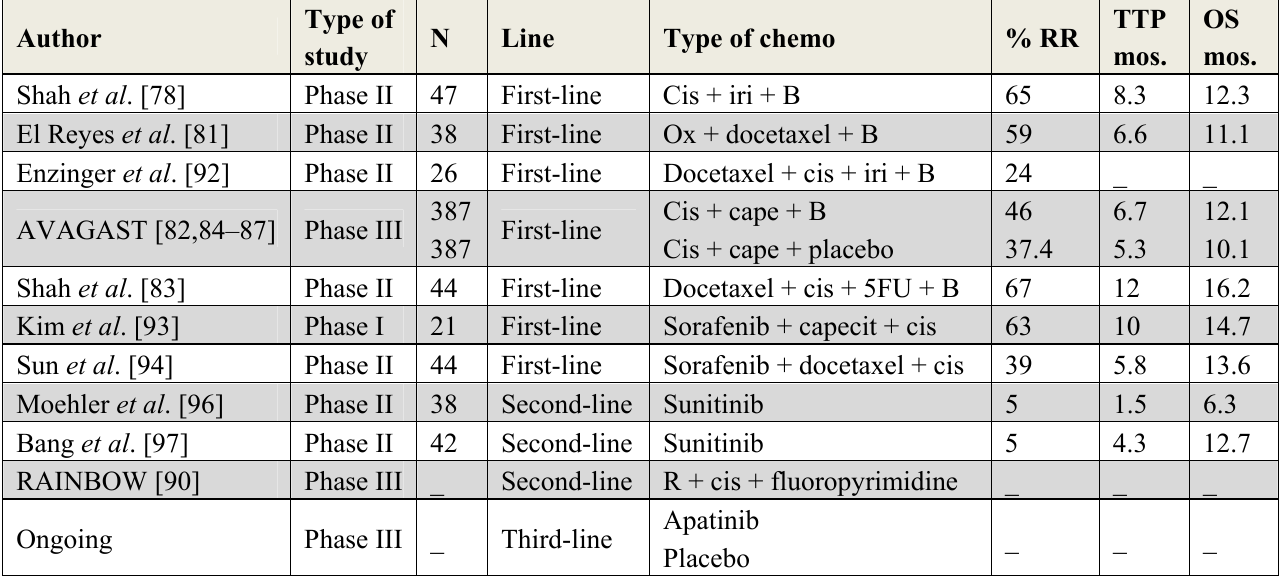
Table 5. Clinical trials with anti-VEGF agents for advanced GC and GEJ